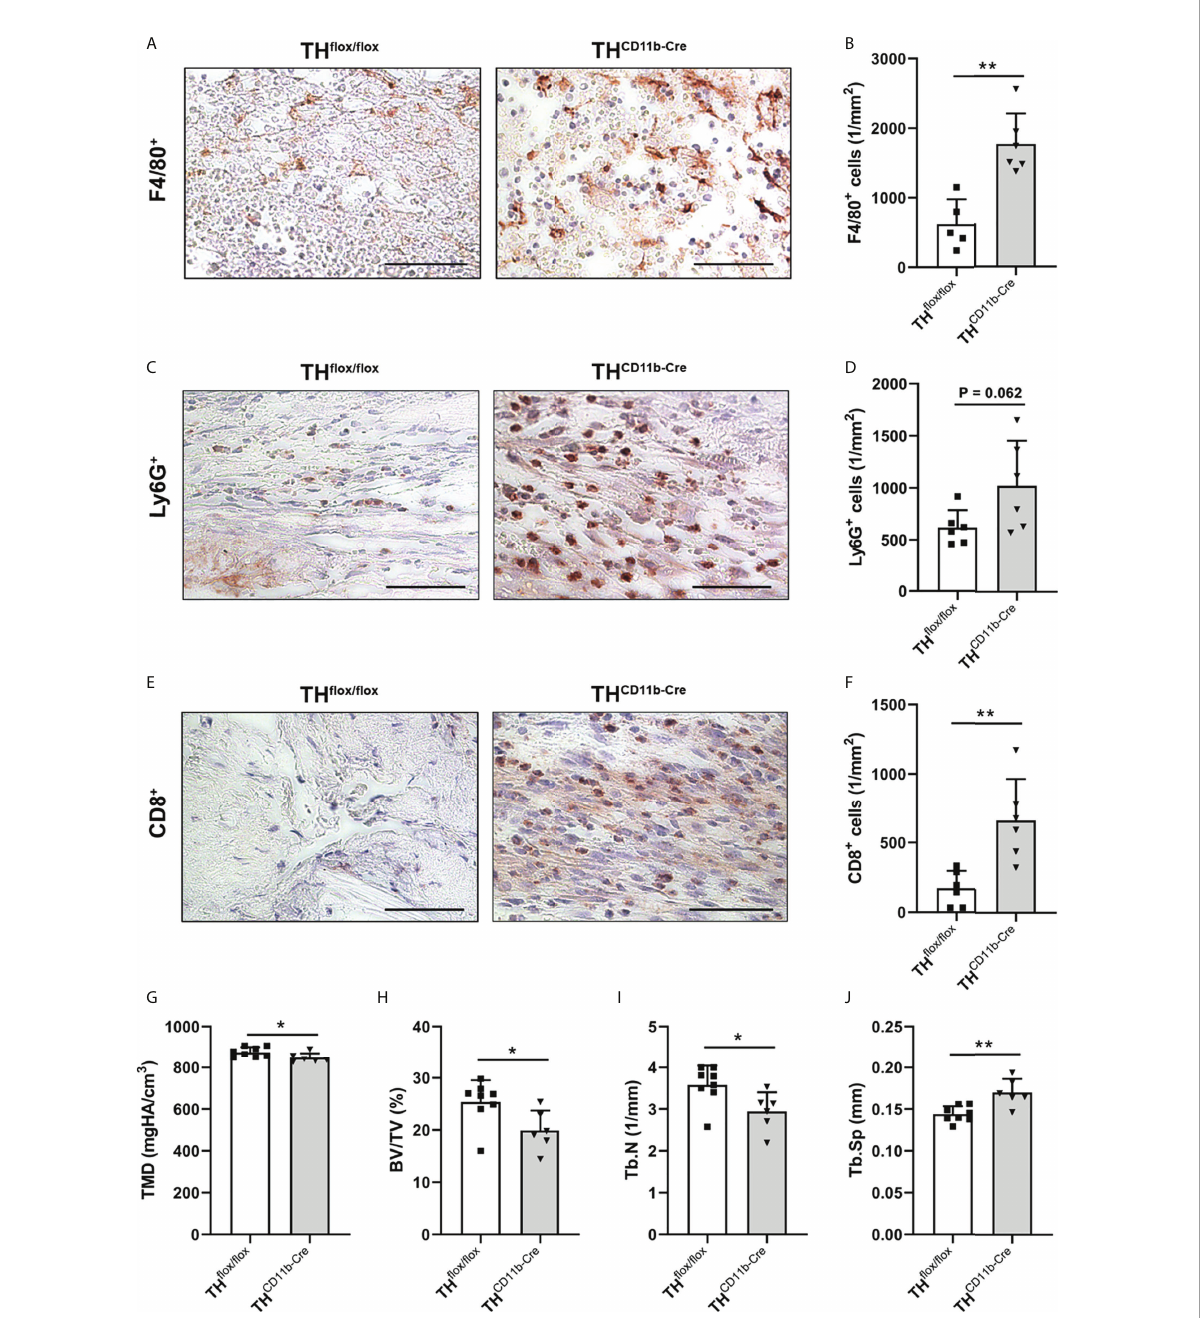
FIGURE 7 Fracture healing in TH CD11b-Cre mice. Immunohistochemical staining and quanti fi cation of (A, B) F4/80 + macrophages, (C, D) Ly6G + neutrophils and (E, F) CD8 + cytotoxic T lymphocytes in the fracture callus of TH fl ox/ fl ox and TH CD11b-Cre mice three days post-fracture. Scale bars represent 50 µm. (G) Tissue mineral density (TMD), (H) bone volume to tissue volume ratio (BV/TV), (I) trabecular number (Tb.N) and (J) trabecular separation (Tb.Sp) in the fracture callus of TH fl ox/ fl ox and TH CD11b-Cre mice 21 days post-fracture. n = 6-8; *P < 0.05; **P <